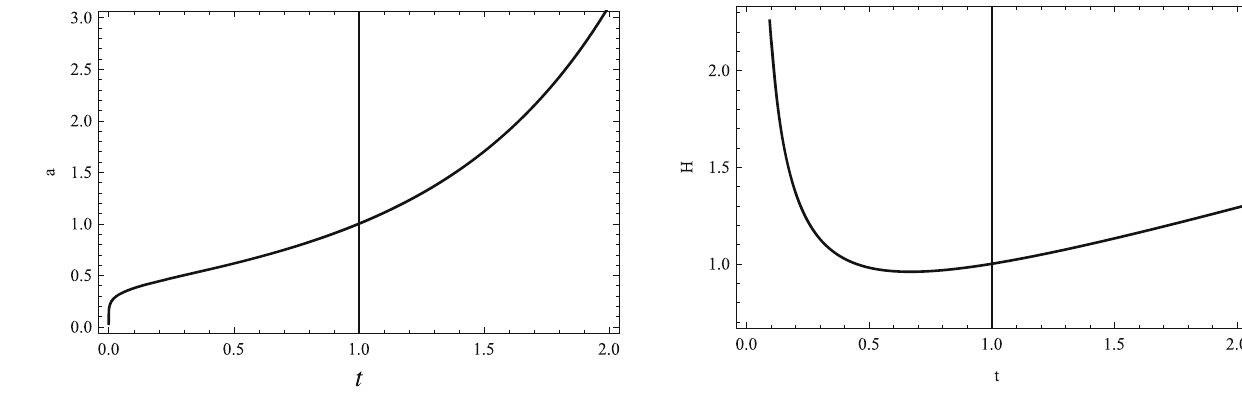
Fig. 1 The evolution of scale factor versus the time t for the values of h 0 = 1 and V 0 = 0 . 28. The vertical line shows the present time t 0 = 1